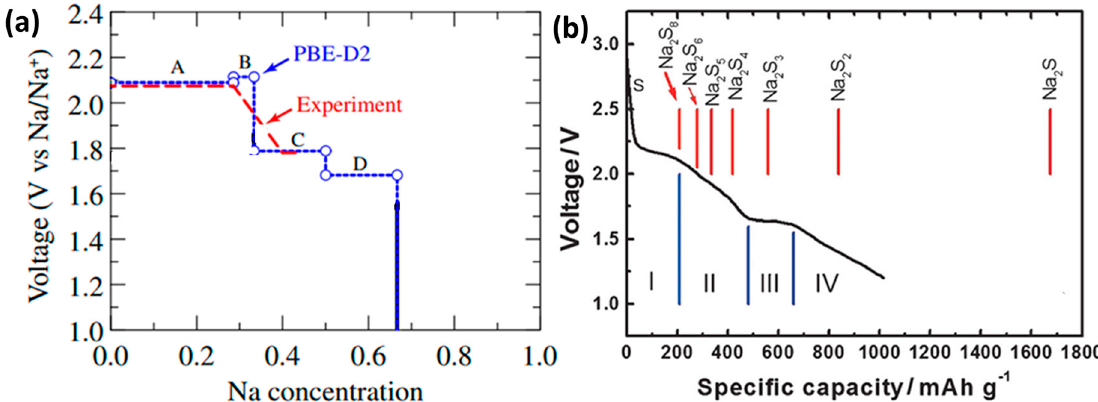
Figure 4. ( a ) Voltages of a Na-S battery as a function of the Na concentration in the cathode. Voltages are calculated by PBED2 ((blue) open circles with dotted line) and experimental voltages ((red) broken line) for molten Na-S batteries measured at about 280–390 °C. ( b ) Discharge curve of room temperature sodium sulfur battery.